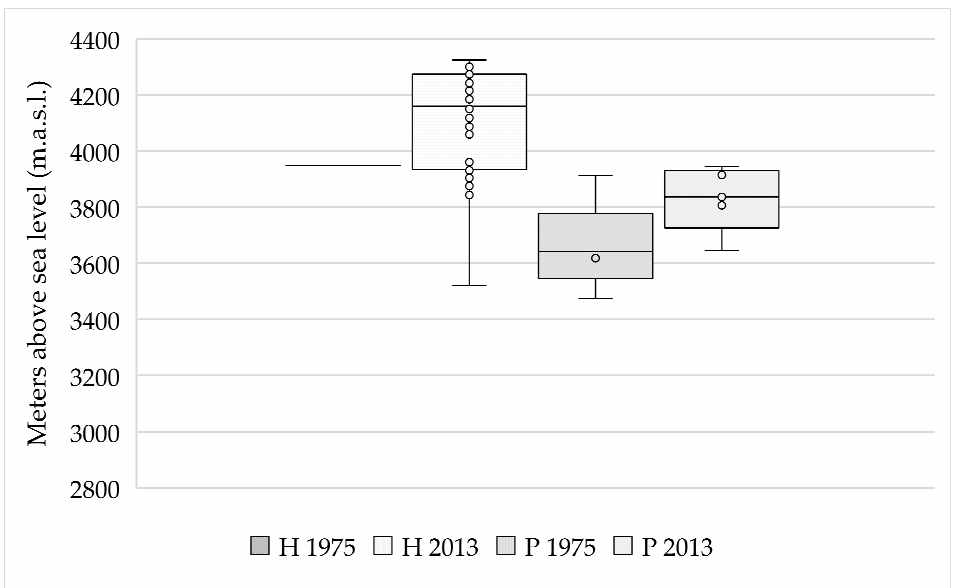
Figure 8. Altitudinal distribution of bitter landraces (1975–2013) in m.a.s.l. (H = Huancavelica, P = Pasco).